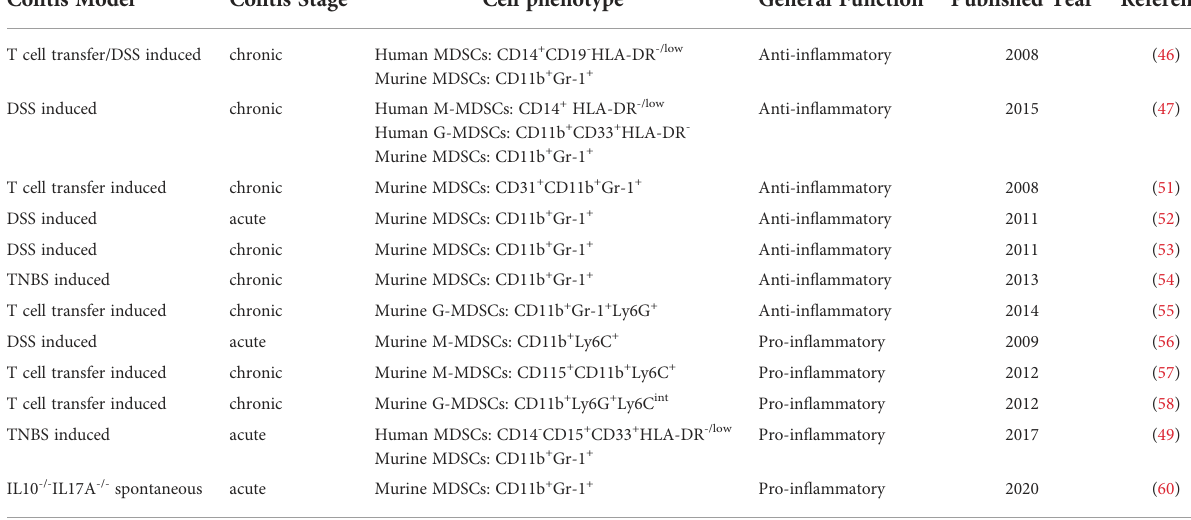
TABLE 1 Phenotypes and Roles of MDSCs in IBD. Colitis